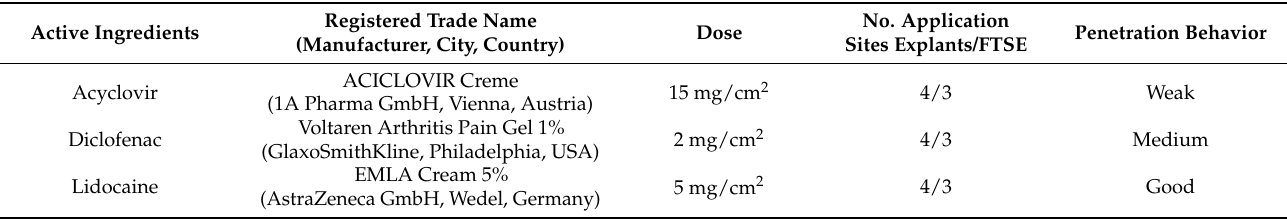
Table 1. List of applied creams with their active ingredients and dosing. Registered Trade Name Active Ingredients (Manufacturer, City,